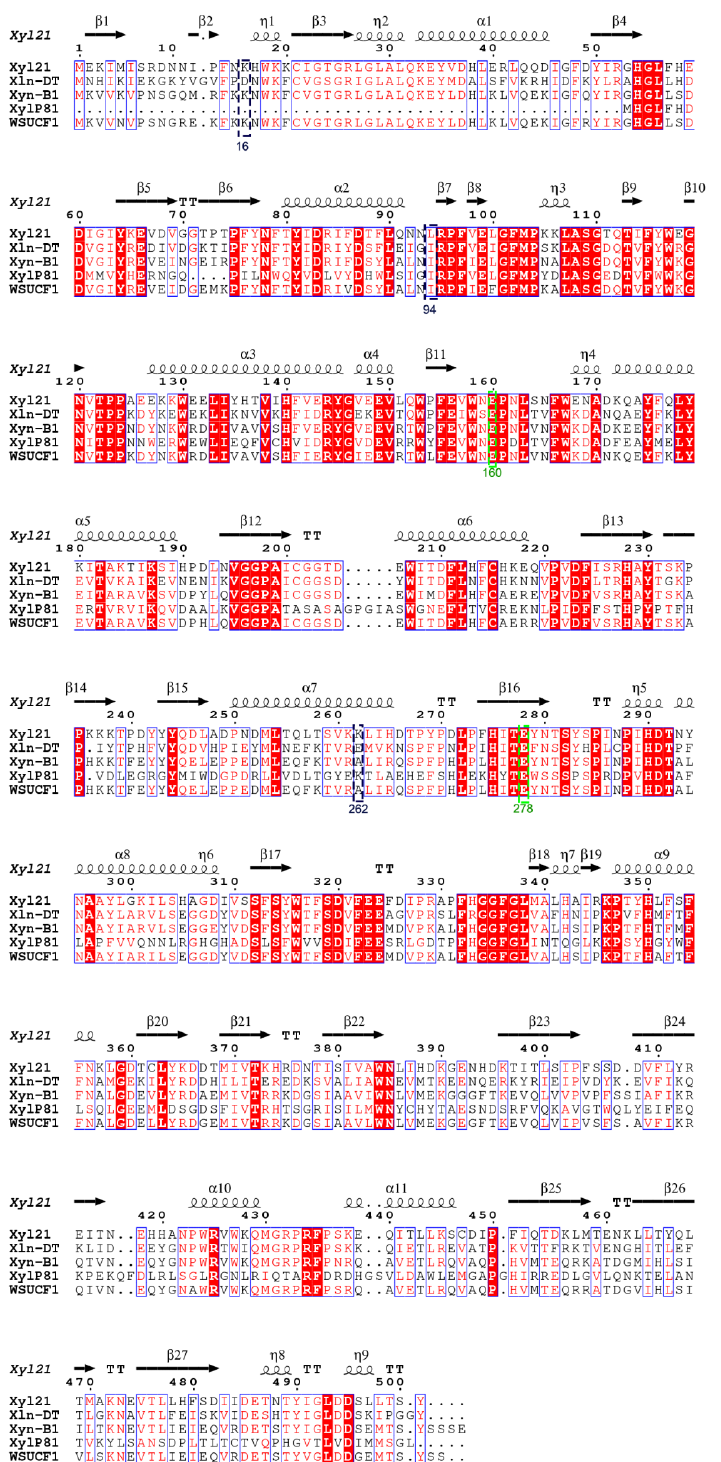
Figure 2. Amino acid sequence alignment of xylosidase Xyl21 and the xylosidases from Dictyoglomus thermophilum (Xln-DT), Geobacillus thermodenitrificans NG80-2 (Xyn-B1), high temperature horse manure compost (XylP81), and Geobacillus sp. (WSUCF1). The same amino acids are marked with a red or light red background. The α -helix and β -sheet secondary structures of Xyl21 are labeled above. The two catalytic glutamic acid residues E160 and E278 are marked by green boxes, and the three mutated sites K16, L94, and K262 were labeled with black